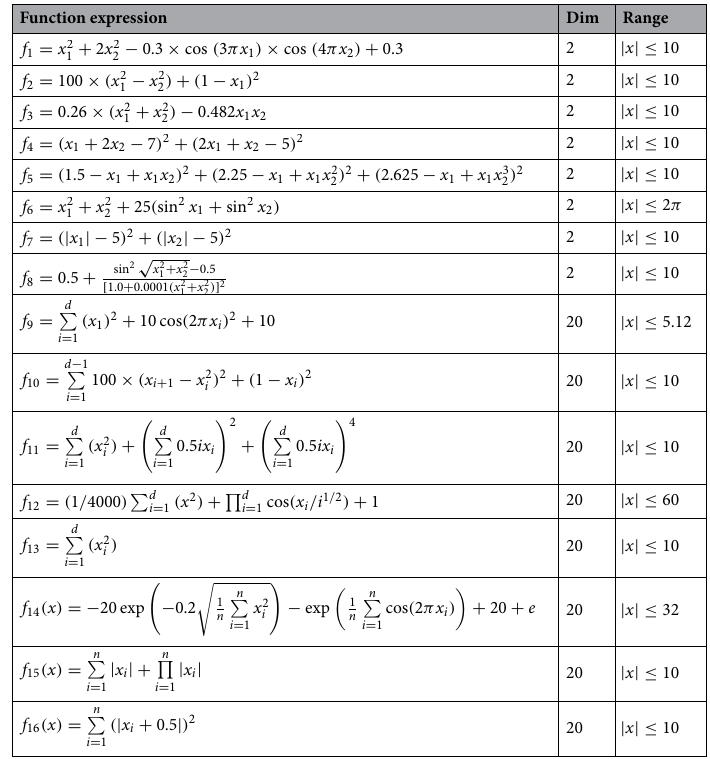
Table 1. Test functions.